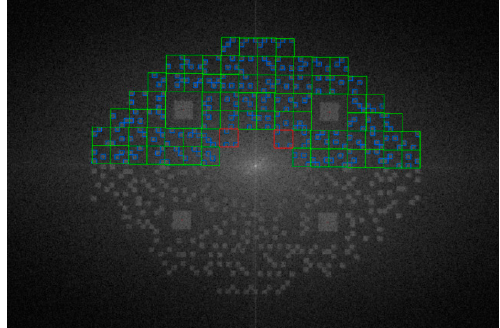
Figure 13. Reconstructed encoded image.